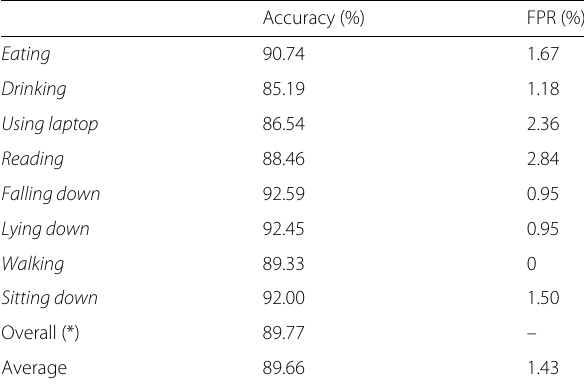
Table 4 Performance of the proposed method on activity classification (8 classes) using Dataset-A : classification accuracy,